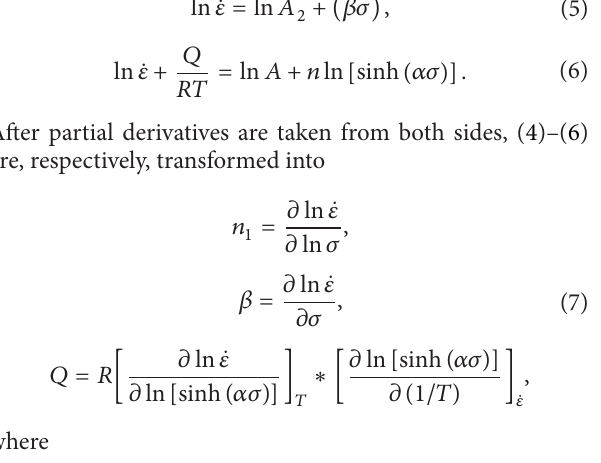
Figure 4: Typical stress-strain curve at the elevated